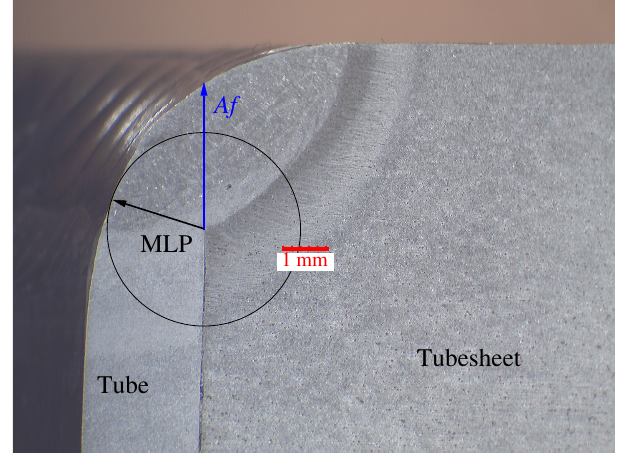
Figure 13. MLP and A f in a macrograph of the tube-to-tubesheet joint.